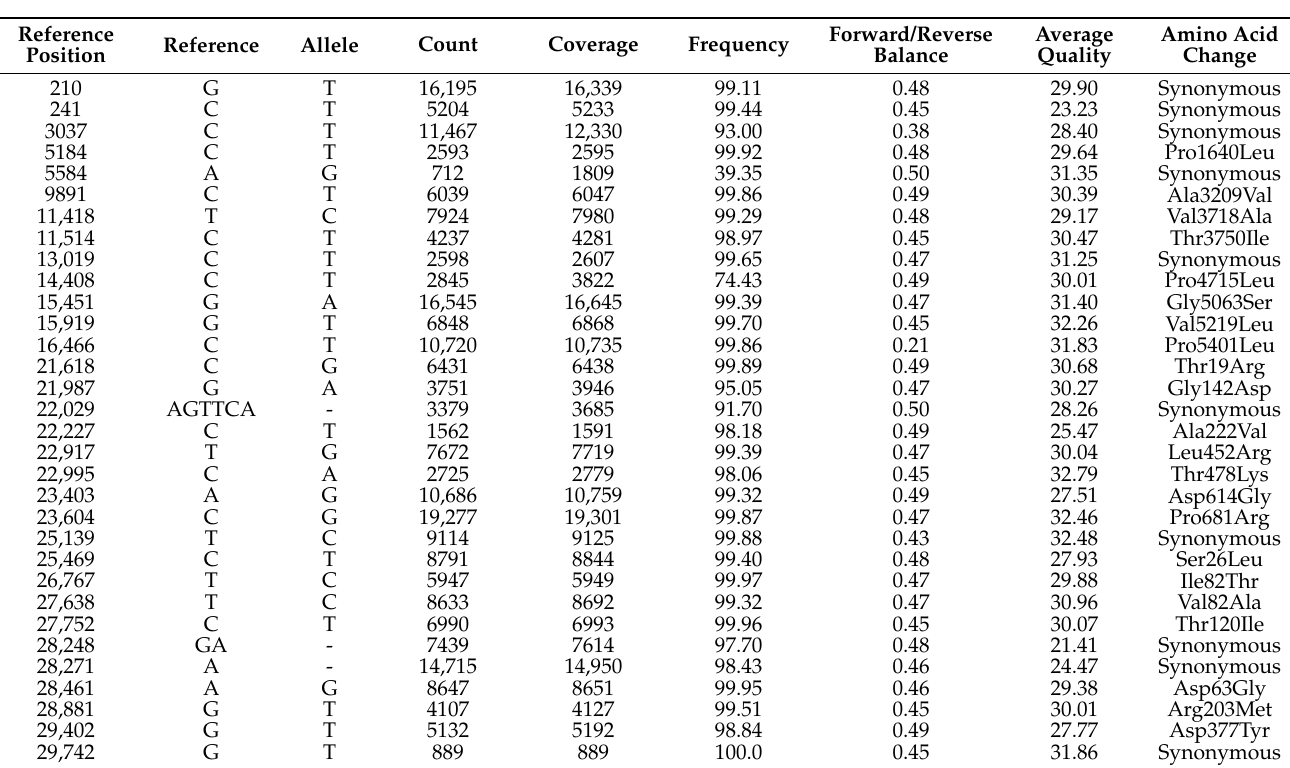
Table 4. Nucleotide changes observed in the whole-genome sequence of SARS-CoV-2 sequenced from a dog (Sample ID: A4N).